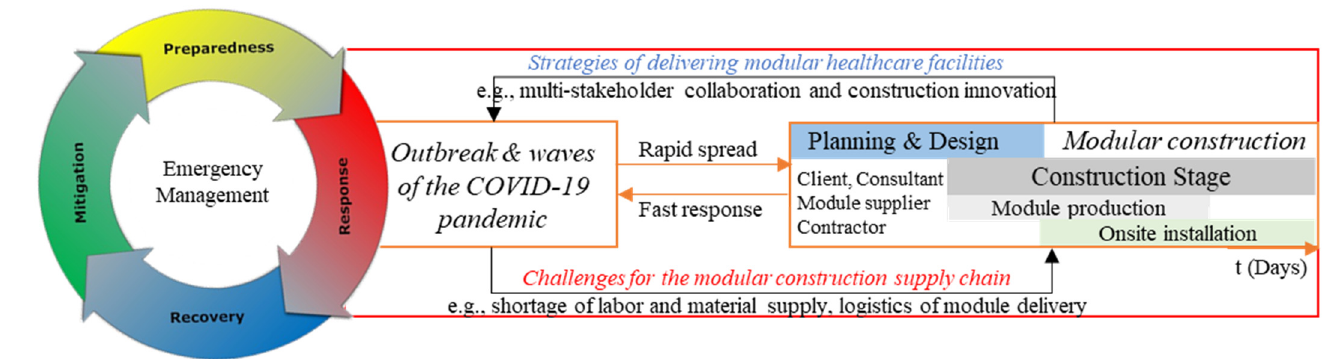
Figure 1. Conceptual framework of modular construction-enabled response to COVID-19.